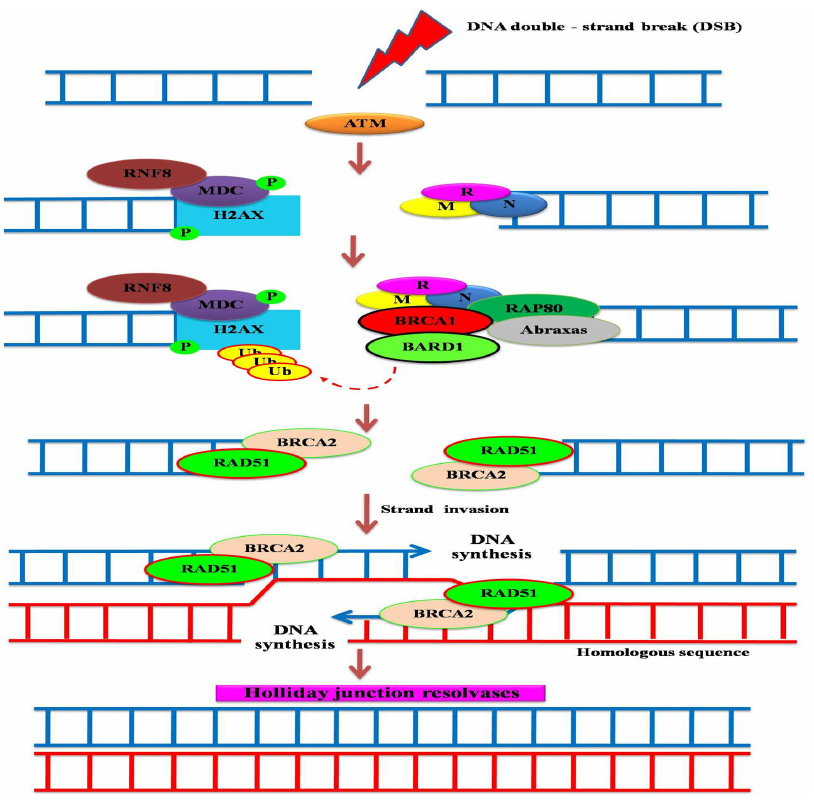
Figure 2. BRCA1-mediated homologous recombination (HR) repair. DNA